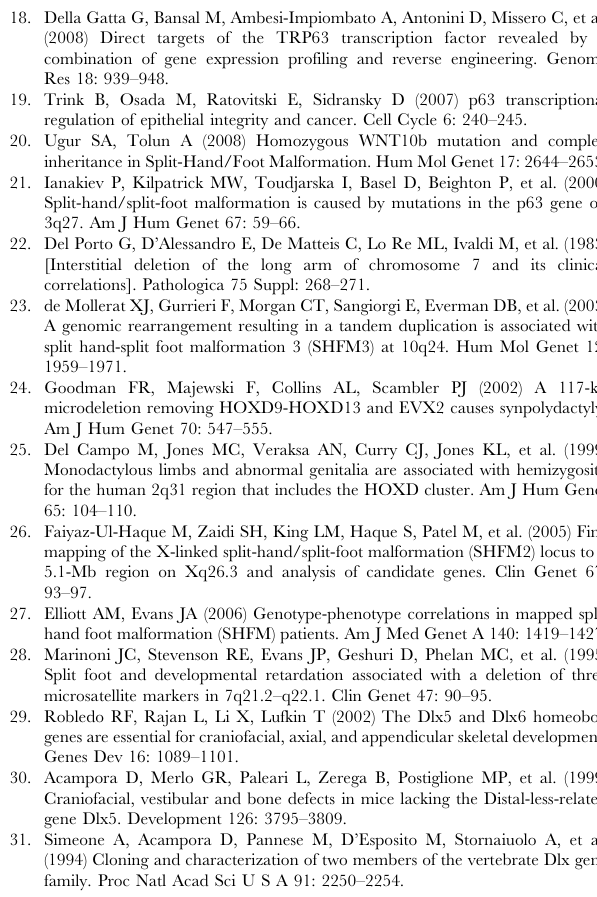
Table S5 OMIM IDs associated with genes containing p63 binding sites.